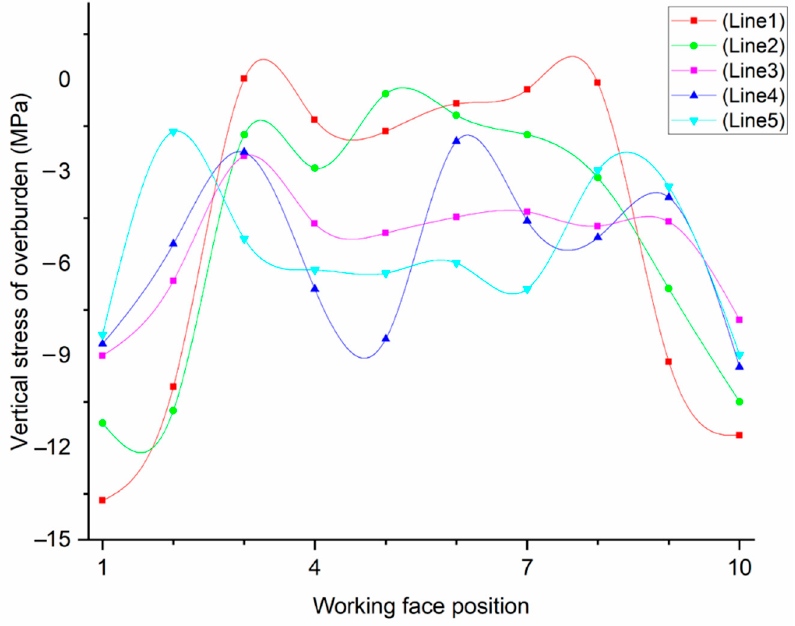
Figure 12. Stress curve diagram of each monitoring point of numerical simulation.